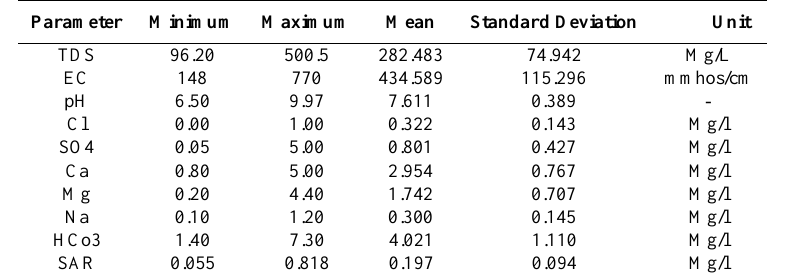
Figure 1 . Location map of Barandoozchay watershed and hydrometric stations. Table 2. Statistical characteristics of observed water quality data in Barandoozchay station .